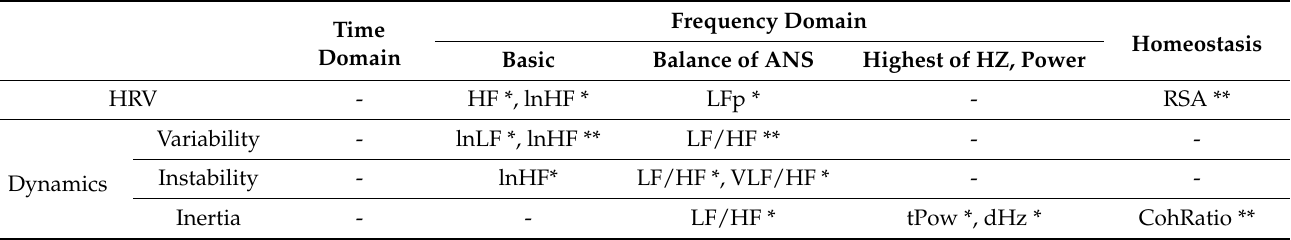
Figure 9. Change in the number of valid HRVs as a function of group composition between low and high groups. Table 7. The 14 significant markers to discriminate high and low EI.